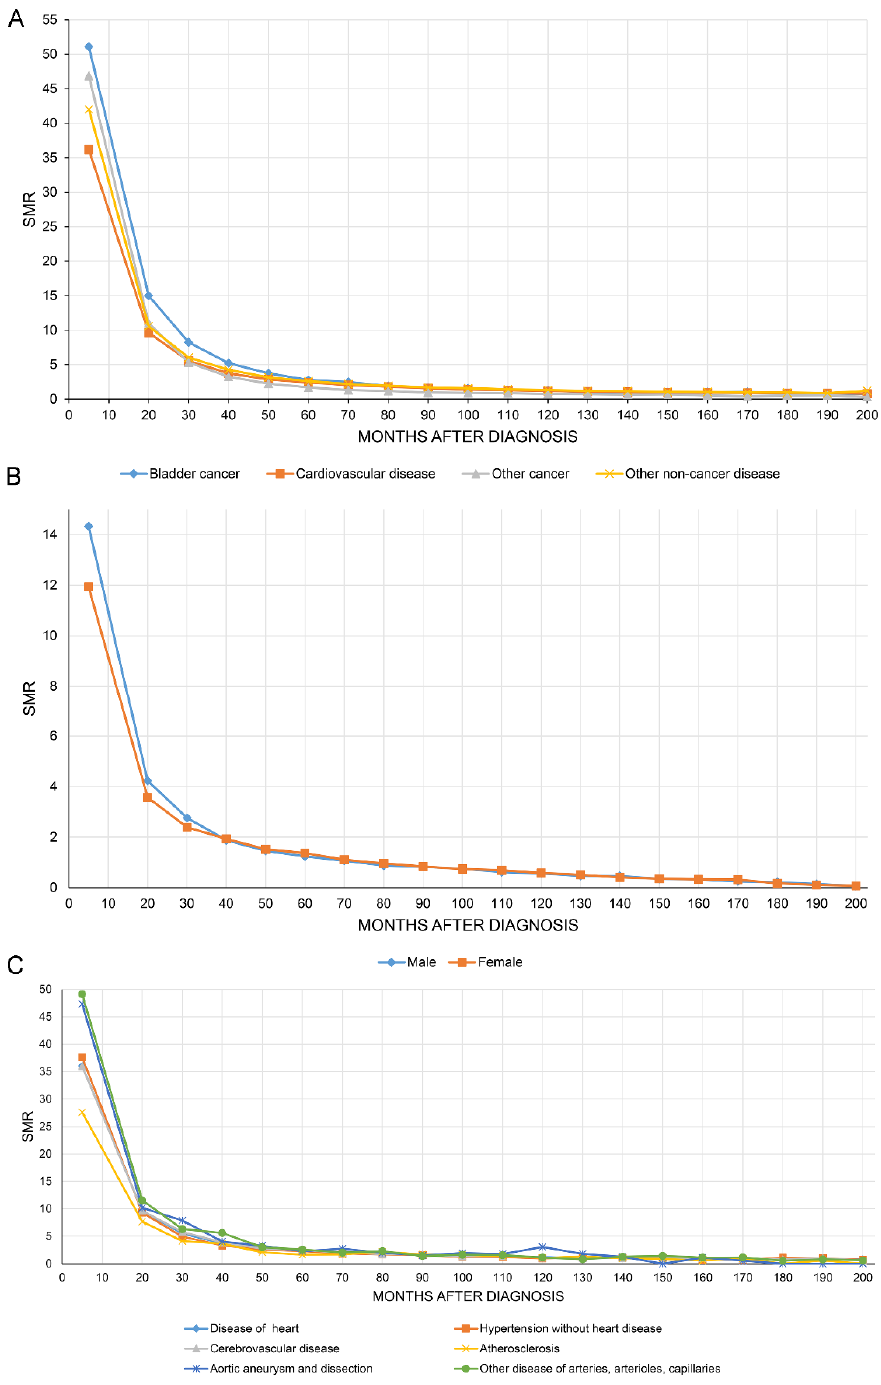
Figure 4. The overall standardized mortality ratio (SMR) of all causes of death in bladder cancer patients decreased with increasing follow-up time ( A ). SMR in cardiovascular disease stratified by sex ( B ) and all causes of cardiovascular mortality ( C ).